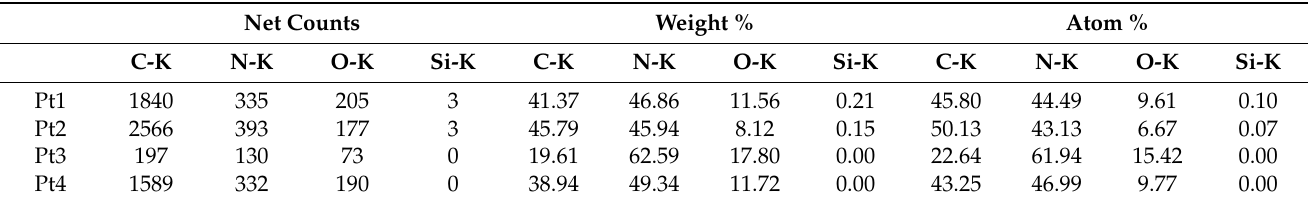
Figure 9. Choosing the analyzed EDX points (1, 2, 3 or 4) in three different zone with defects of the part: ( a ) EDX points in Base(18) area; ( b ) EDX points in Base(19) area; ( c ) EDX points in Base(20) area